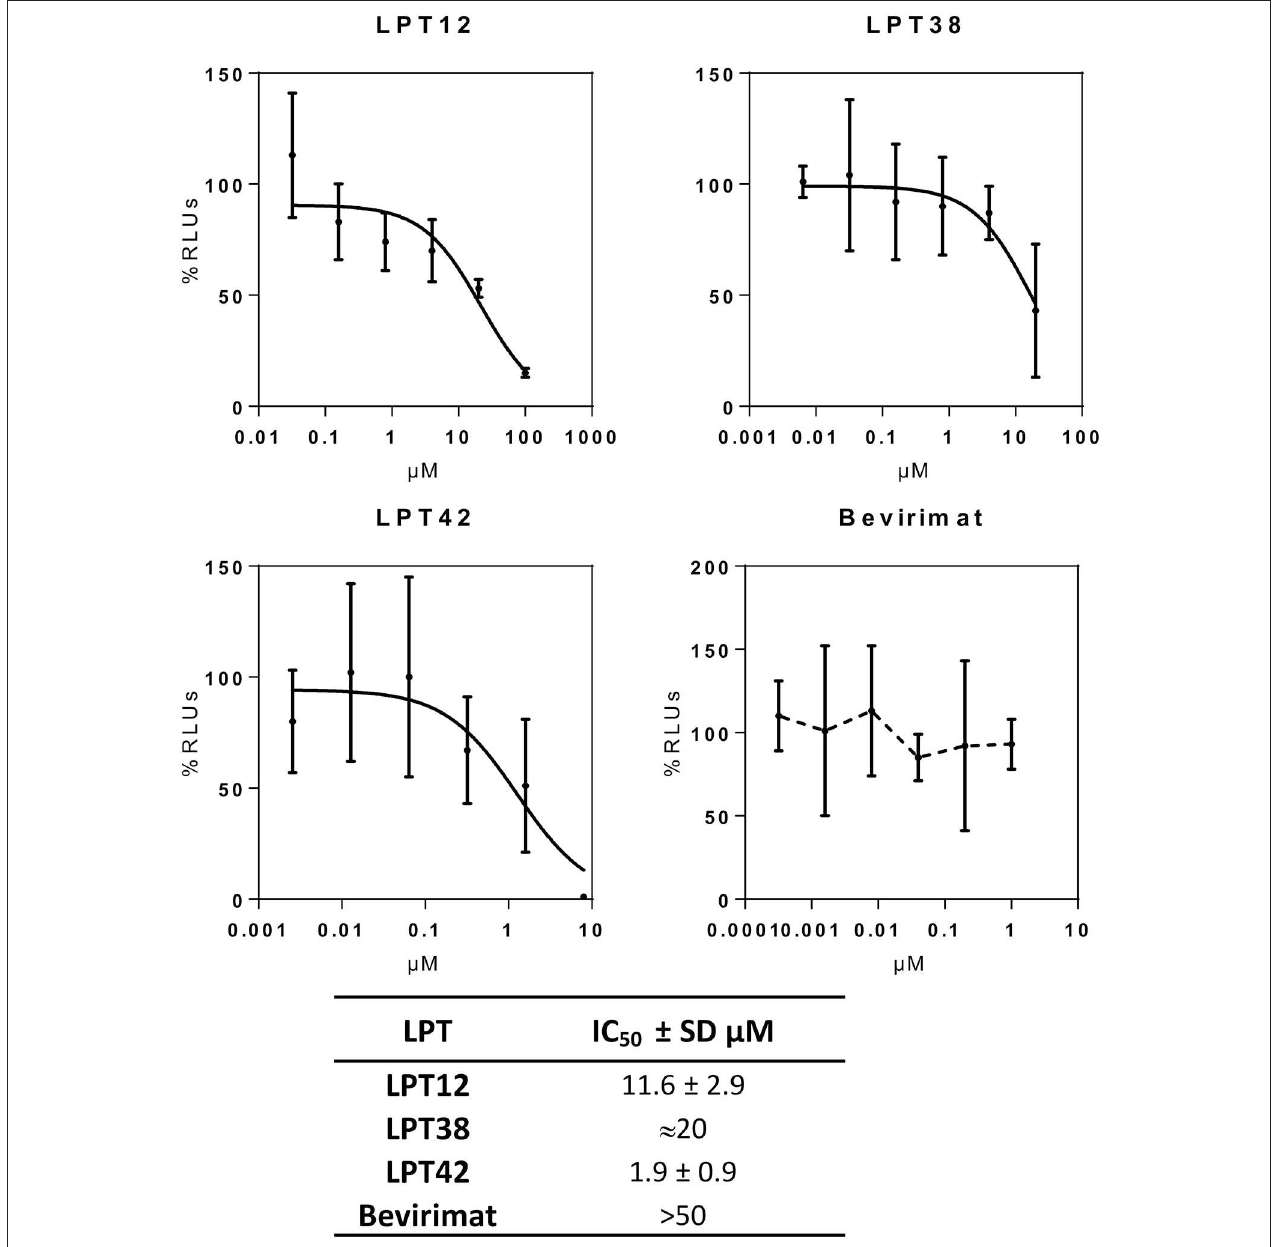
FIGURE 5 | HIV-1 transcriptional activity of selected LPTs. MT-2 cells were transfected with a luciferase construct under the control of the whole HIV-1 genome (pNL4.3-Luc) in the presence of different concentrations of LPTs or bevirimat. Data are shown as % RLUs as compared to an untreated control (100%). Concentrations are shown in µ M. IC 50 s were calculated using GraphPad Prism software. SD, Standard